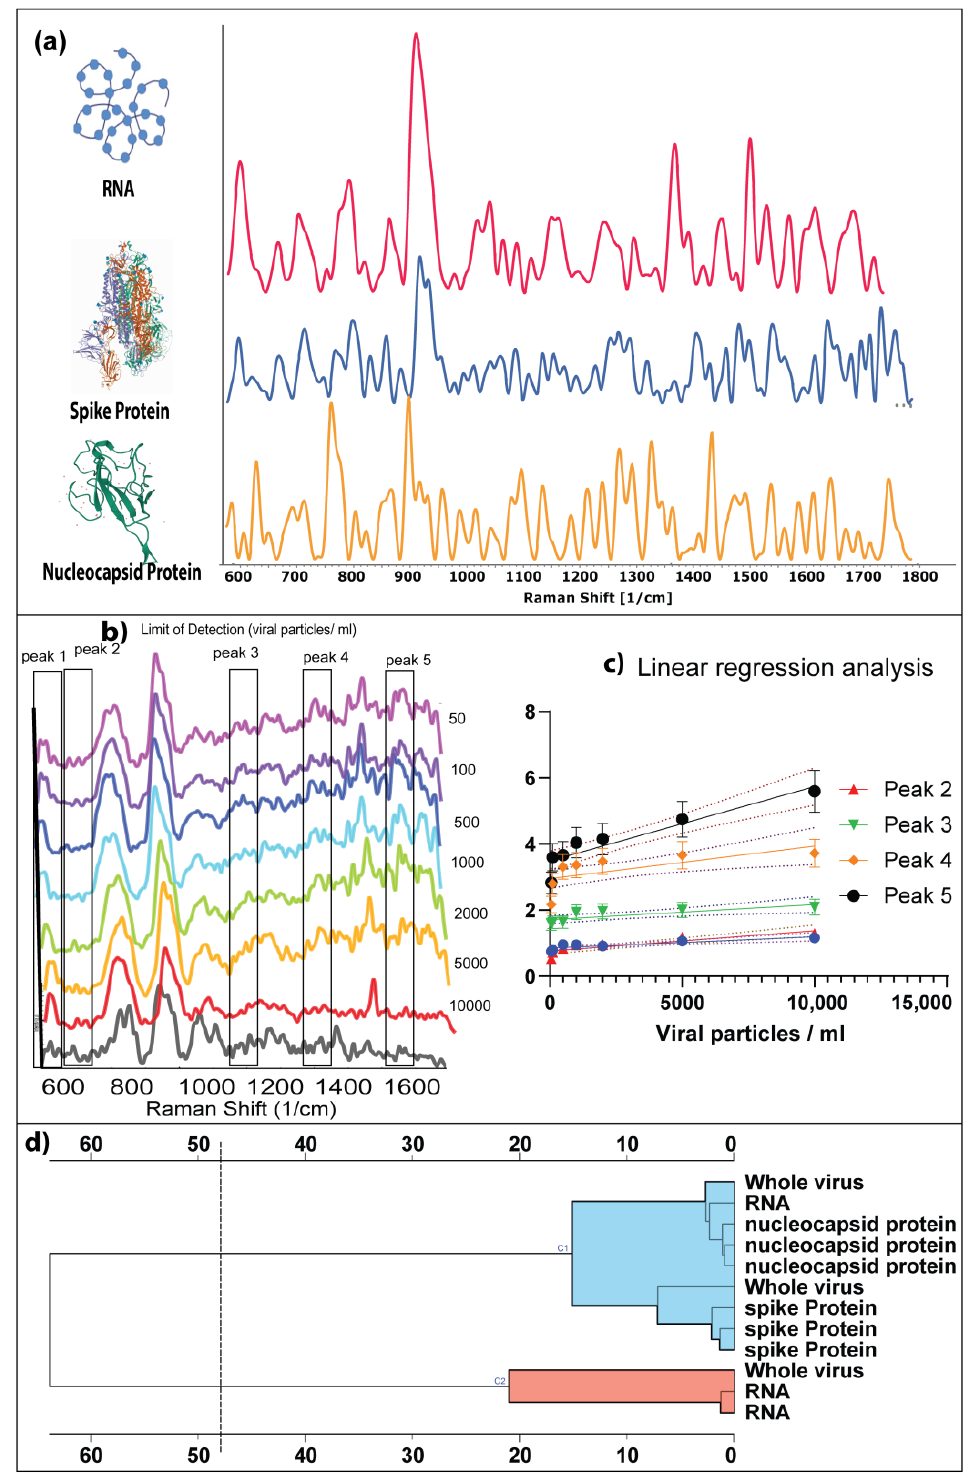
Figure 3. ( a ) Establishing the unique SERS signature of SARS-CoV-2 viral components. Analytical sensitivity of Label-free SERS assay by determining the limit of detection of the nanostructured sensor ( b ) SERS spectra of whole virus particles spiked in saliva varying from 10,000 particles to 50 particles per ml of saliva ( c ) Linear regression analysis based on the limit of detection ( d ) Hierar- chical clustering analysis showing the cluster similarities between whole virus particles and their structural components.